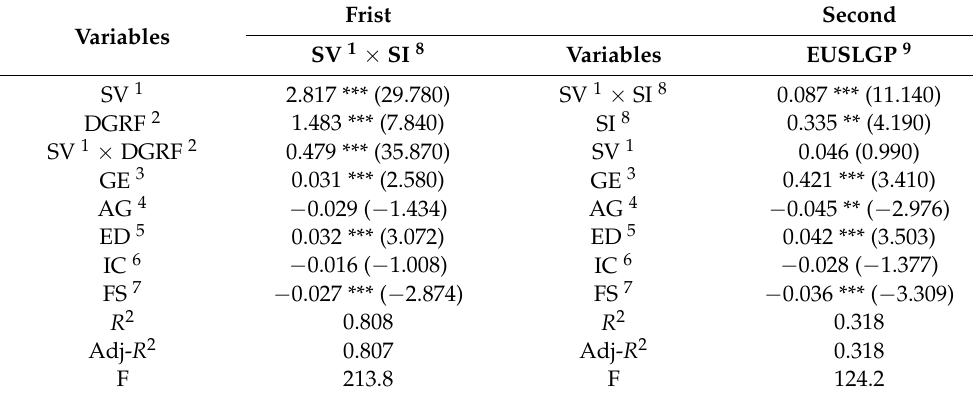
Table 4. Endogenous test